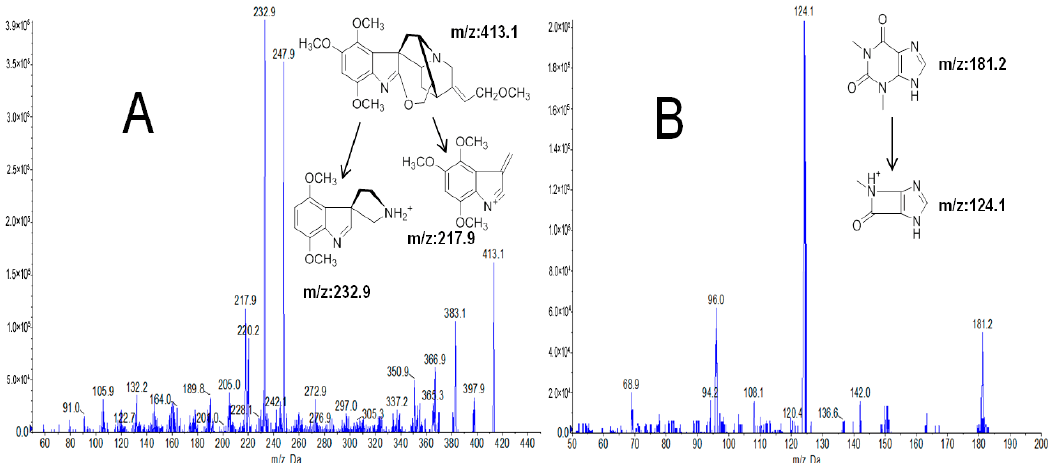
Figure 1. Mass spectra and structures of gardneramine ( A ) and internal standard (I.S.) ( B ). Table 1. Optimized mass spectrometry conditions for the determination of gardneramine and I.S.